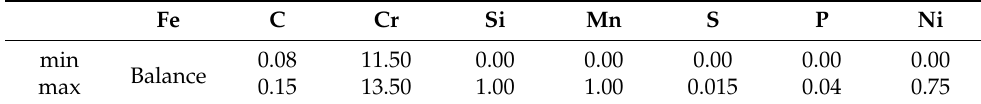
Table 1. Chemical composition of X2CrNi12 used for